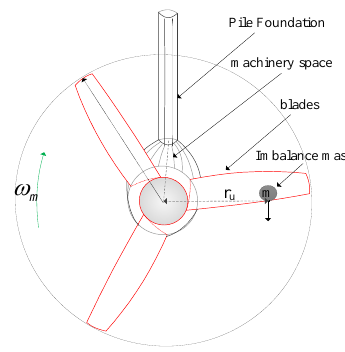
Figure 2. E ff ect of imbalance mass on the Figure 2. Effect of imbalance mass on the MCT. Figure 2. Effect of imbalance mass on the MCT.